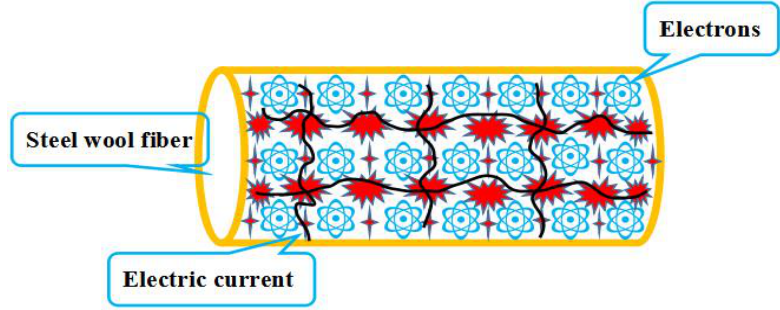
Figure 7. The generation process diagram of induction current.